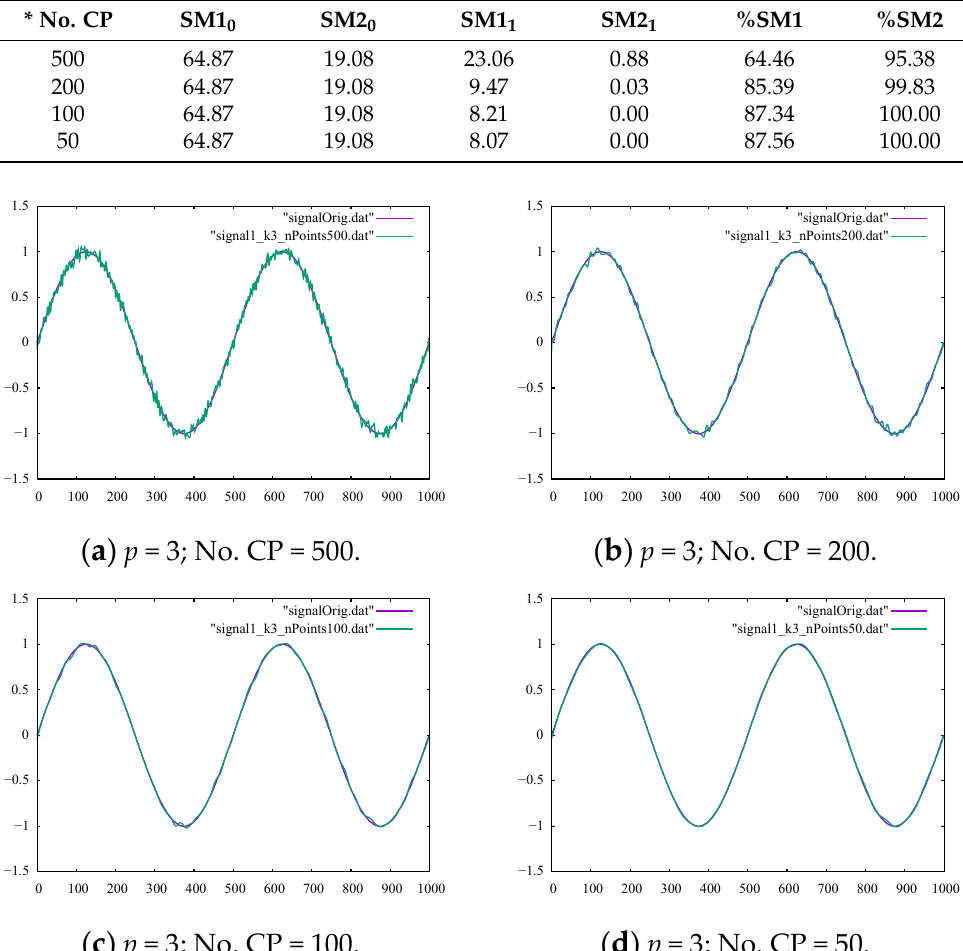
Figure 3. The output of the B-spline filter with the ground-truth sine signal for comparison using ( a ) 500, ( b ) 200, ( c ) 100, and ( d ) 50 control points.